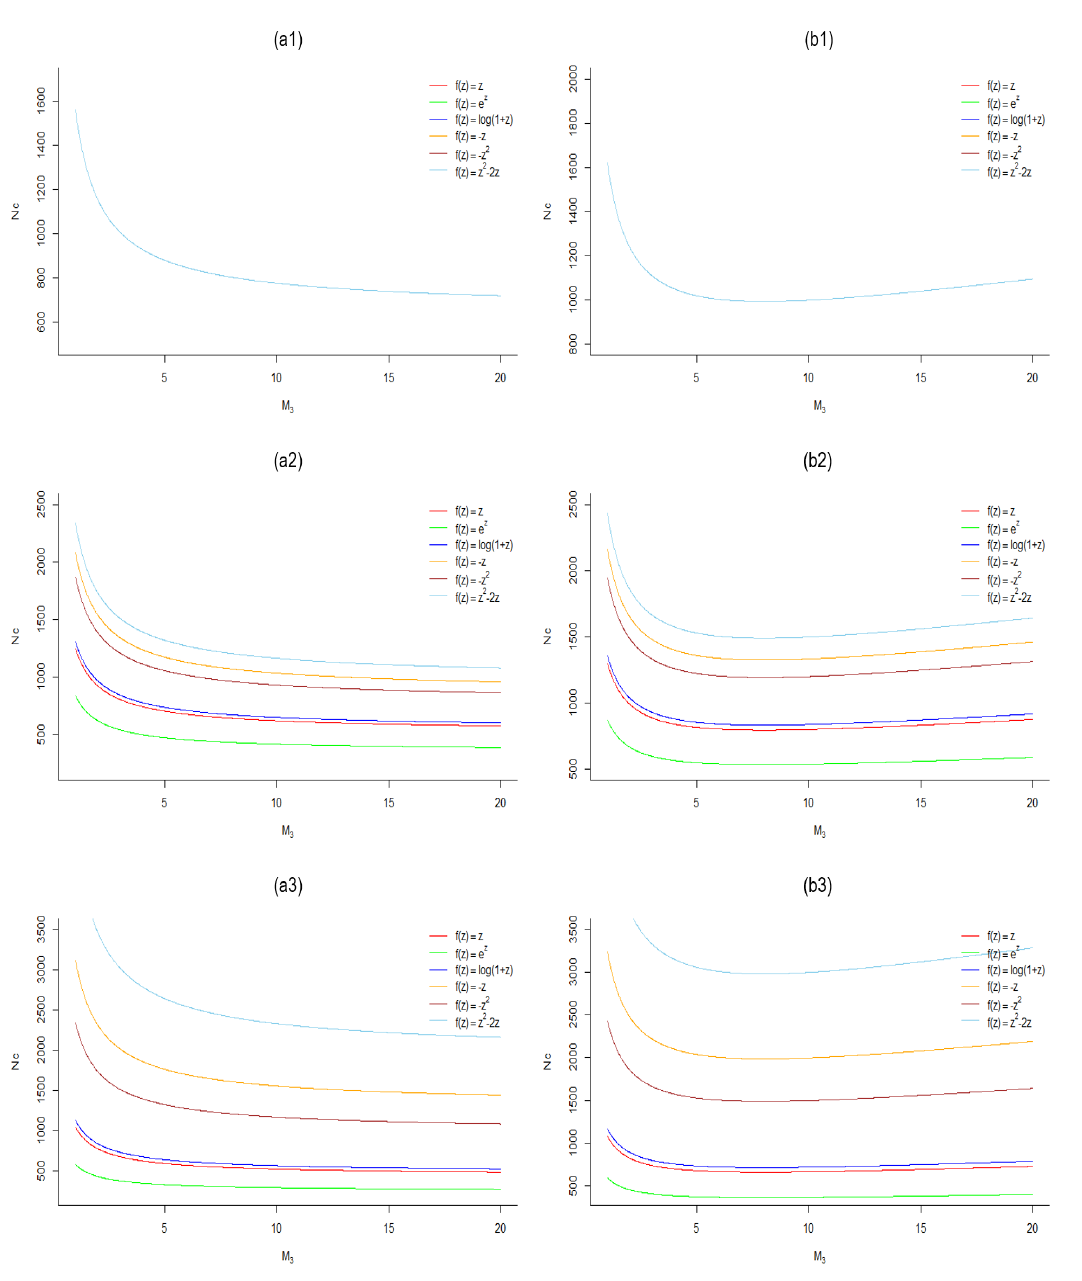
Figure 7. For different changeable gravity functions, relationship between N c and M 3 for (cid:101) = 0 and δ = 0 in ( a1 ), for (cid:101) = 0 and δ = 0.08 in ( b1 ), for (cid:101) = 0.5 and δ = 0 in ( a2 ), for (cid:101) = 0.5 and δ = 0.08 in ( b2 ), for (cid:101) = 1 and δ = 0 in ( a3 ), for (cid:101) = 1 and δ = 0.08 in ( b3